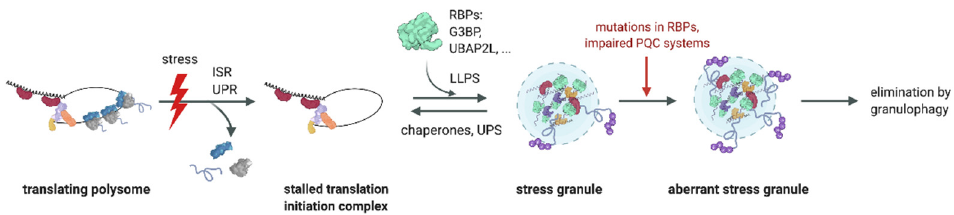
Figure 1. SG assembly and disassembly. Various types of stress induce translational arrest and poly- some disassembly via the integrated stress response (ISR) and unfolded protein response (UPR) pathways. 40S ribosomal subunits, translation initiation factors, mRNPs, and RBPs condensate into SGs via liquid–liquid phase separation (LLPS). RBPs such as G3BP and UBAP2L are central nodes of the protein–RNA network driving LLPS. SGs are disassembled with the help of molecular chaperones and the ubiquitin proteasome system (UPS), allowing translation to recommence. Mutations in RBPs or impairment of protein quality control (PQC) systems mediating SG disassembly promote the transformation into aberrant SGs, accumulating misfolded proteins that are partially modified with ubiquitin chains (purple circles). Aberrant SGs are removed via a selective autophagy pathway termed